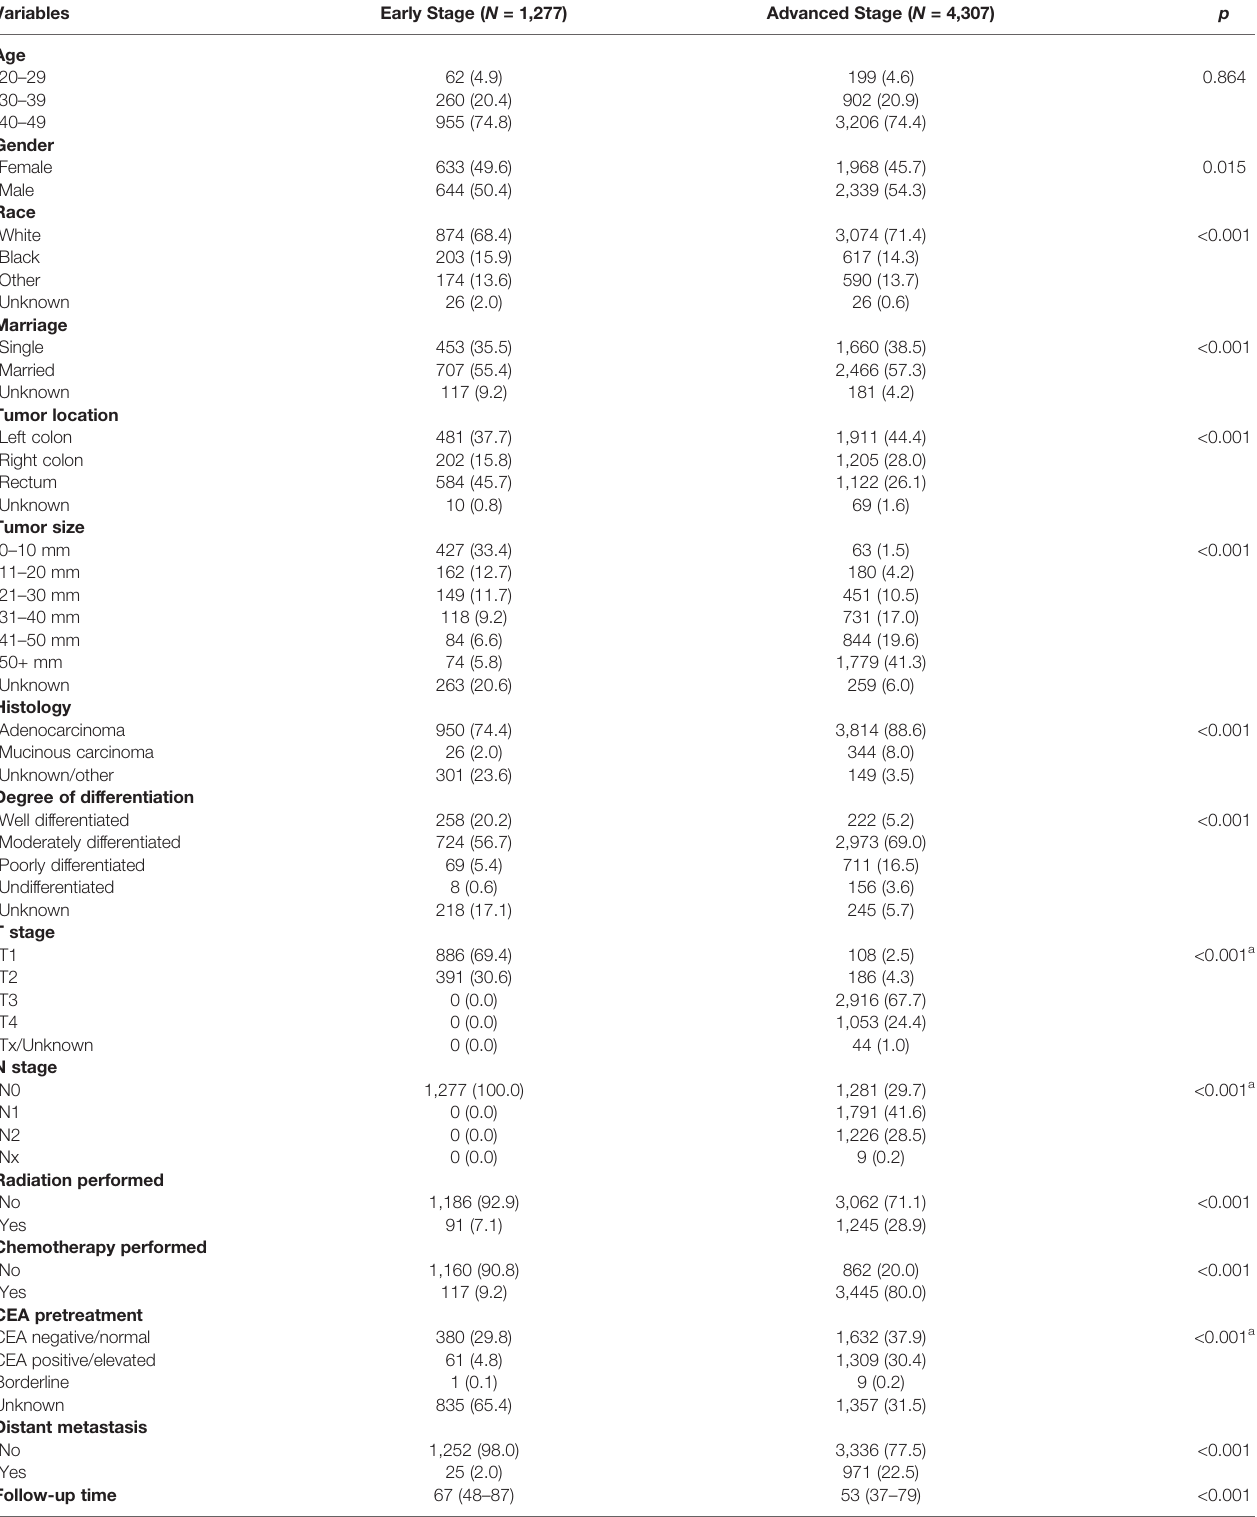
TABLE 2 | Clinicopathological characteristics of young-onset colorectal cancer between early stage and advanced